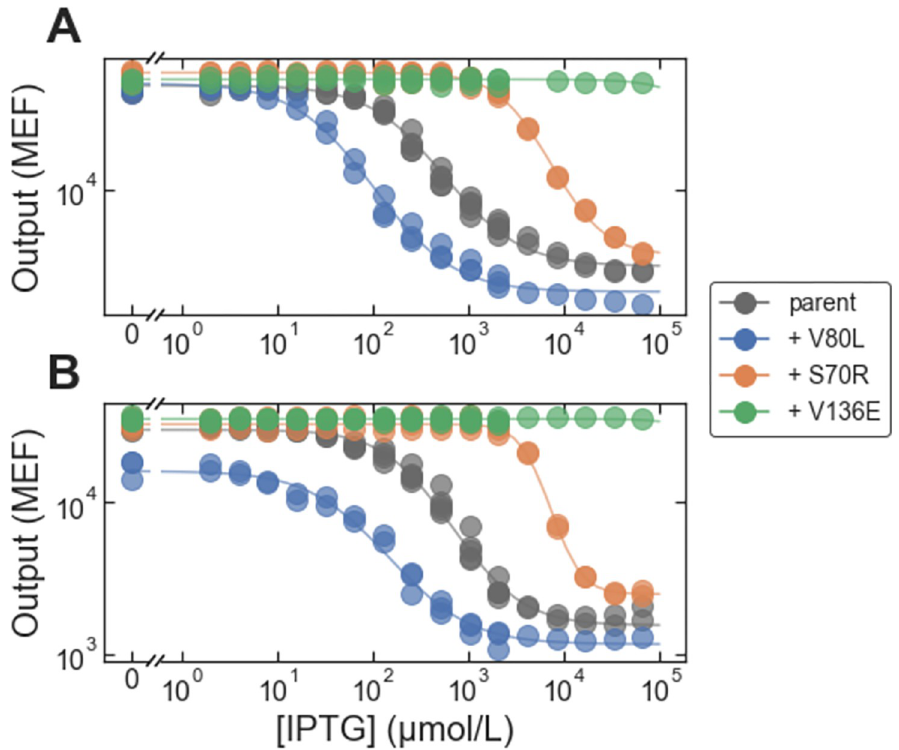
Fig 9. Forward engineering to improve inverted sensors. Each plot shows dose-response curves for a ‘parent’ inverted LacI variant and for that parent with the addition of mutations chosen to improve the inverted variant (by reducing EC 50 and G 1 ). (A) The parent variant has three missense mutations: A87P, V301M, and E357G. (B) The parent variant has five missense mutations: V96E, T154I, S158R, V238D, M254I, and